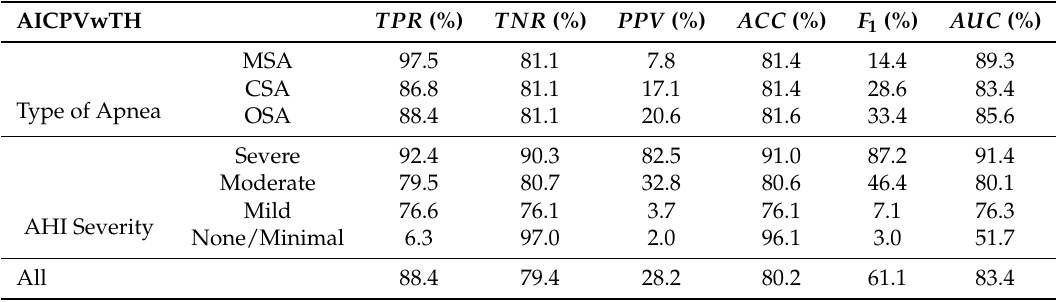
Table 5. Test performance of AICPV with threshold classifier over different types of apnea and different apnea severities.